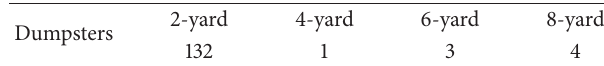
Table 2: Distribution of dumpsters on MU